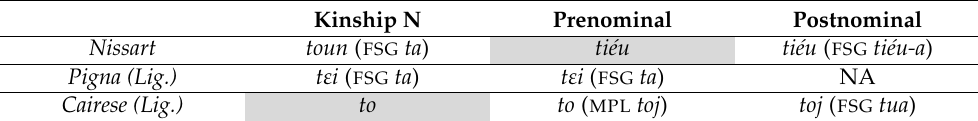
Table 14. The possessives form “your” with kinship nouns vs. other nouns. Grey cells contain non-agreeing forms. Kinship N Prenominal Pigna (Lig.) t ε i ( FSG ta ) NA Cairese (Lig.) to to ( MPL toj ) toj ( FSG tua